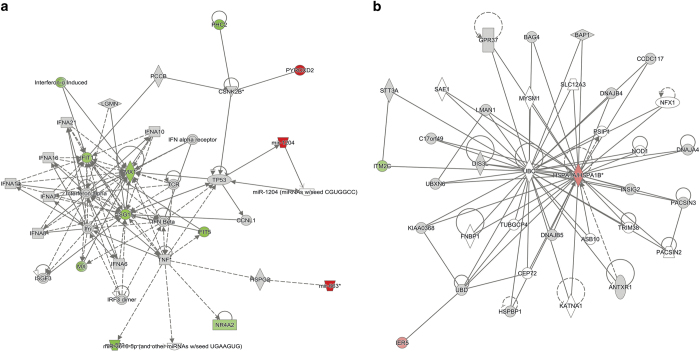
Differentially expressed genes between U266100 and U26610 in (a) cells and (b) tumours. (red – upregulated in U26610; green – downregulated in U26610, fold change >2, P<0.05).